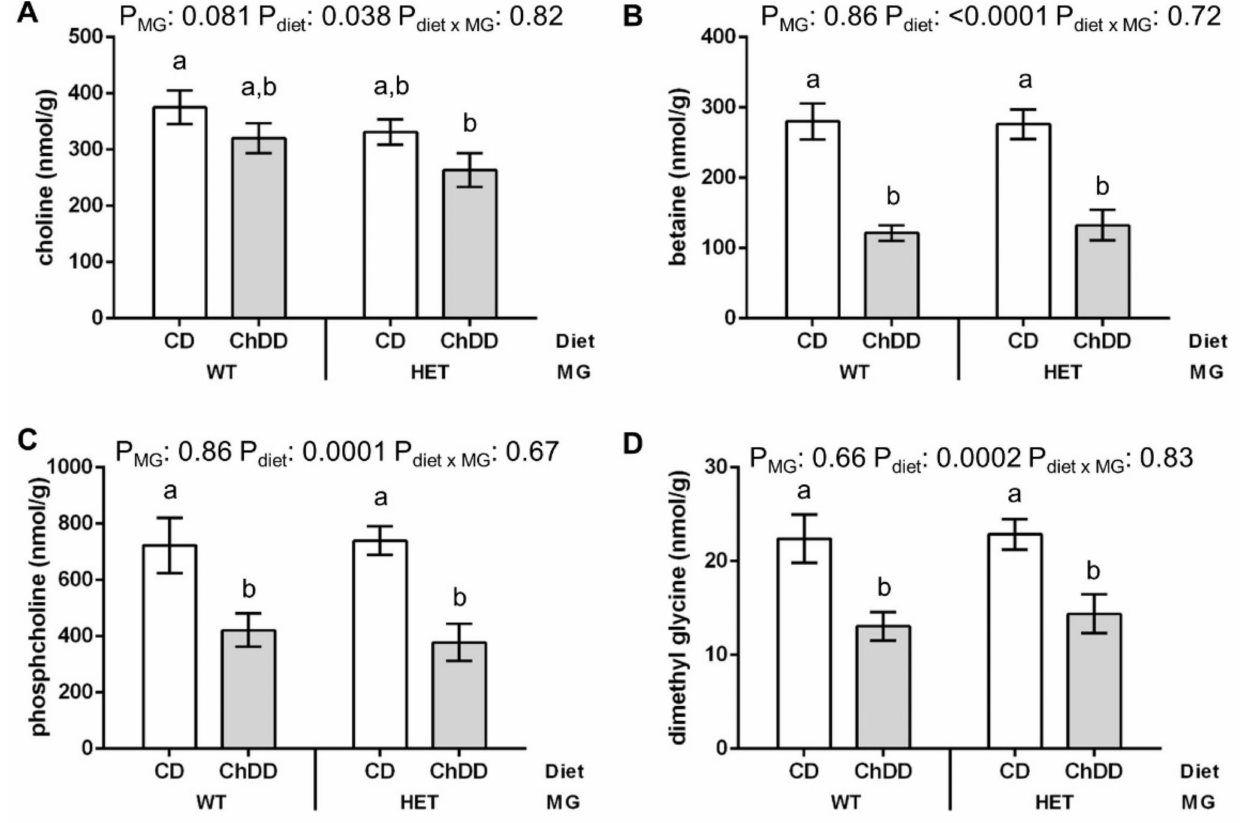
Figure 3. Effect of maternal synthetase activity and low choline diet on choline and methyl metabolites in maternal liver. Values are means ± SEM, n = 6 per group. Choline ( A ), betaine ( B ), phosphocholine ( C ), and dimethylglycine ( D ) were significantly lower in ChDD livers. Analysed by 2-way ANOVA; means without a common letter differ significantly by Tukey post hoc ( p < 0.05). White bars: CD, grey bars: